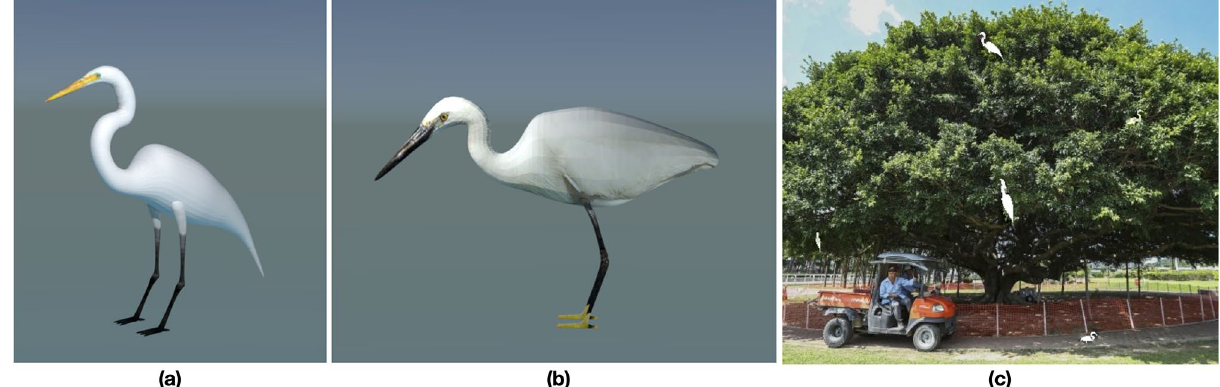
Figure 2. Application of domain randomization to enhance the accuracy of the detection models. Virtual great egret ( a ) and little egret ( b ) were created with the open-source 3D graphics toolset Blender. Synthetic image ( c